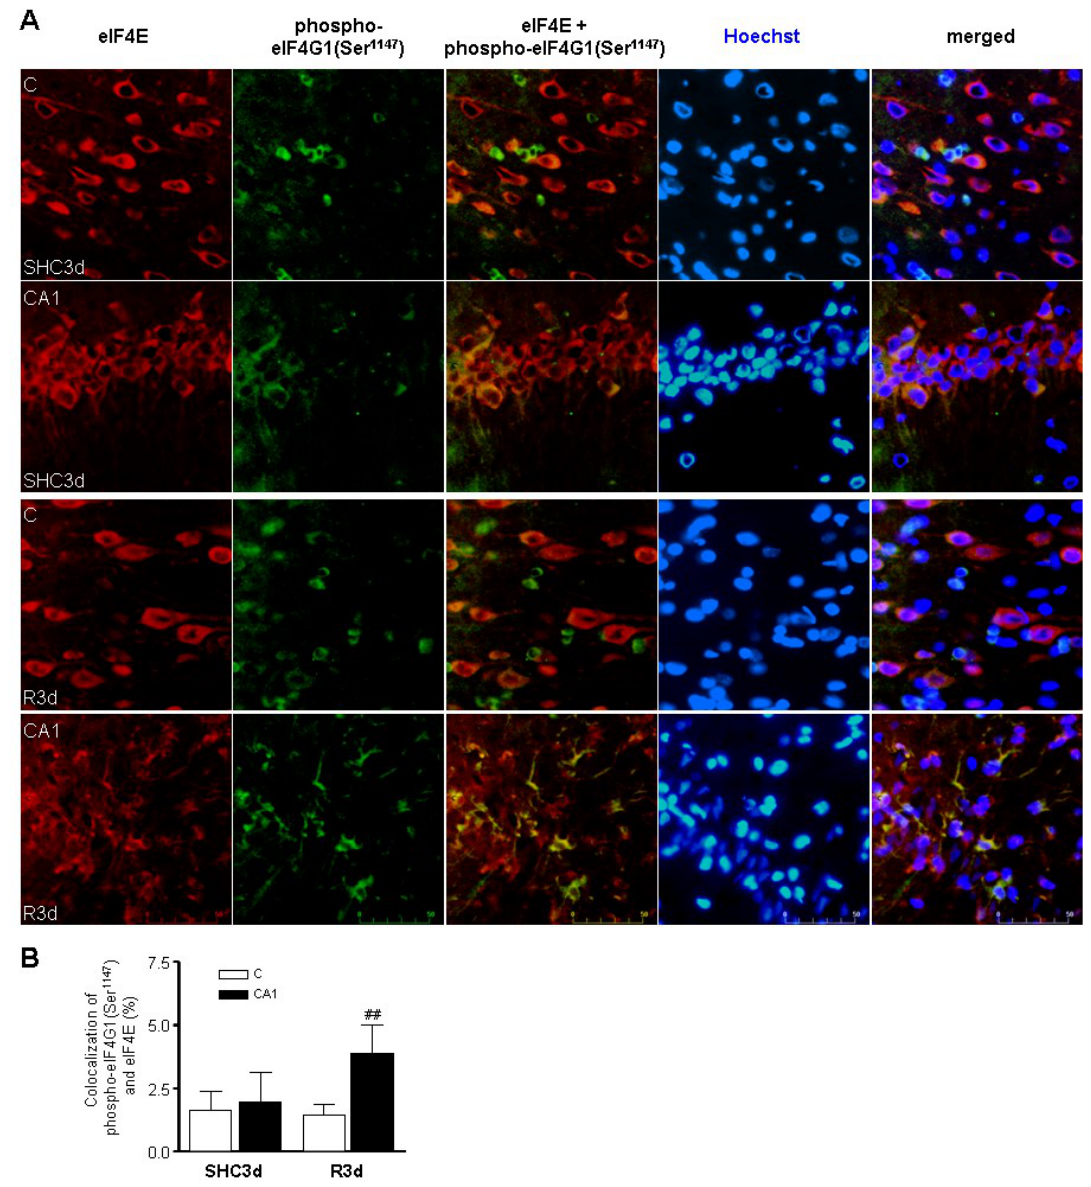
Figure 5. Colocalization of eIF4G1 phosphorylated at Ser 1147 and eIF4E in the cerebral cortex and hippocampal CA1 re- gions induced by ischemia-reperfusion stress. ( A ) Brain sections of cerebral cortex (C) or hippocampal CA1 region from control (SHC3d) and ischemic animals with reperfusion (R3d), were used for eIF4E and eIF4G1 phosphorylated at Ser 1147 colocalization study by confocal fluorescence microscopy. eIF4E was visualized using Alexa Fluor 568 secondary anti- body (red) while phospho-eIF4G1 at Ser 1147 was visualized with Alexa Fluor 488 secondary antibody (green). Cell nuclei were stained with Hoechst 33342 dye (blue). Green and red channels were merged and colocalized components are shown in yellow (eIF4E +phospho-eIF4G1, central images). Merged images display the eIF4E (red), phospho-eIF4G1 (green) and Hoechst (blue) signal. Images are representative results from four to six different animals and are full origi- nal scanned images. Scale bar, 50 μm. ( B ) Quantification of eIF4G1 phosphorylated at Ser 1147 and eIF4E colocalization. The degree of colocalization is expressed by the percentage of green objects colocalizing with red objects in the scanned area. Data are from four to six different animals; error bars indicate SE. ## p < 0.01 by Newman–Keuls post-test after sig- nificant ANOVA ( p < 0.05), compared with their control and with the cerebral cortex.